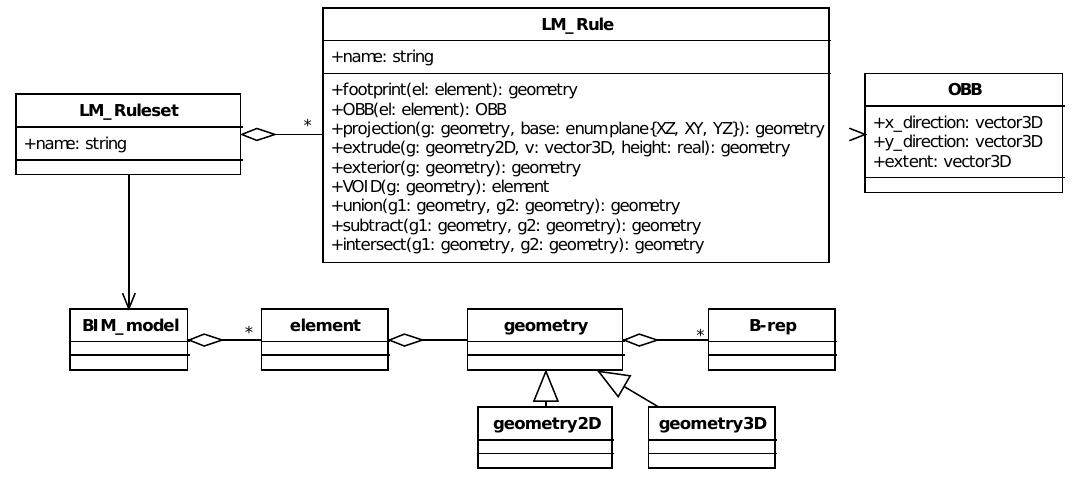
Figure 15. B2G LM concept diagram (UML).